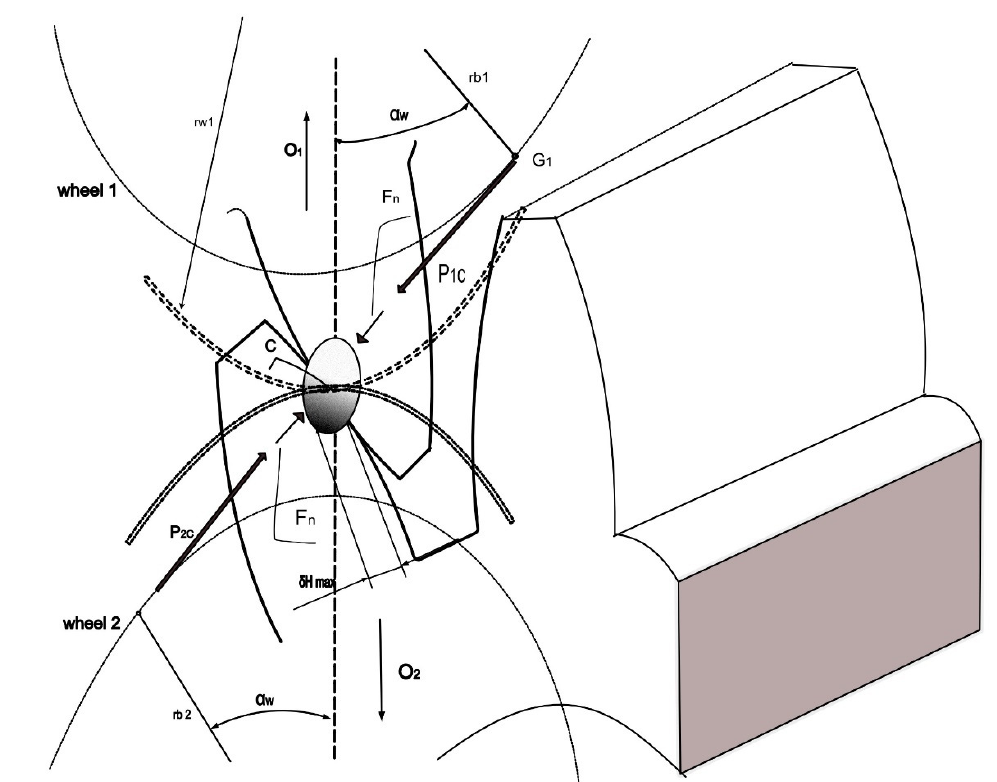
Figure 4. The distribution of contact stresses on the surface of the mating wheels (C—pressure point, σ —stress, ρ —radiuses of the curvature, α w —angle of the contour, F n —peripheral force).